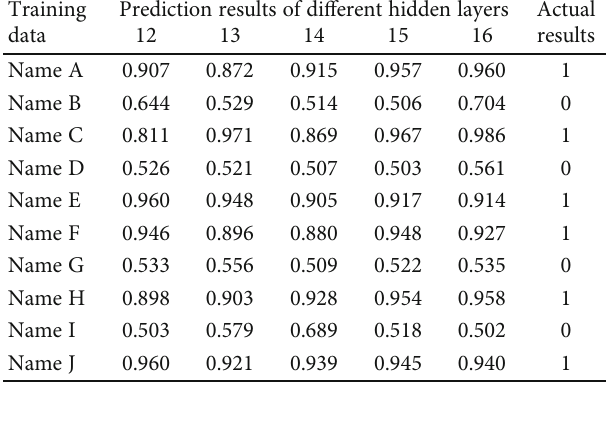
Table 1: Data simulation of di ff erent hidden layer neuron number. Training Prediction results of di ff erent hidden layers data